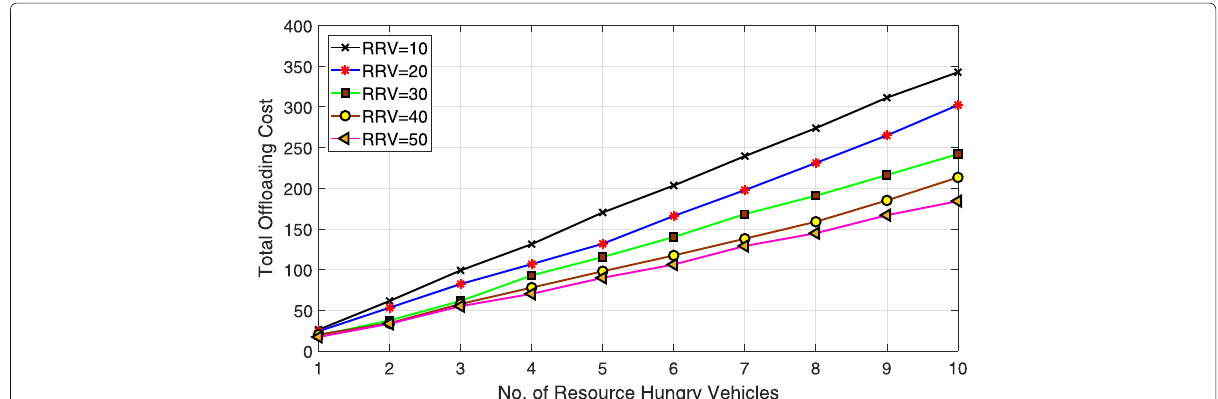
Fig. 3 The total offloading cost versus varying RHVs with fixed No. of